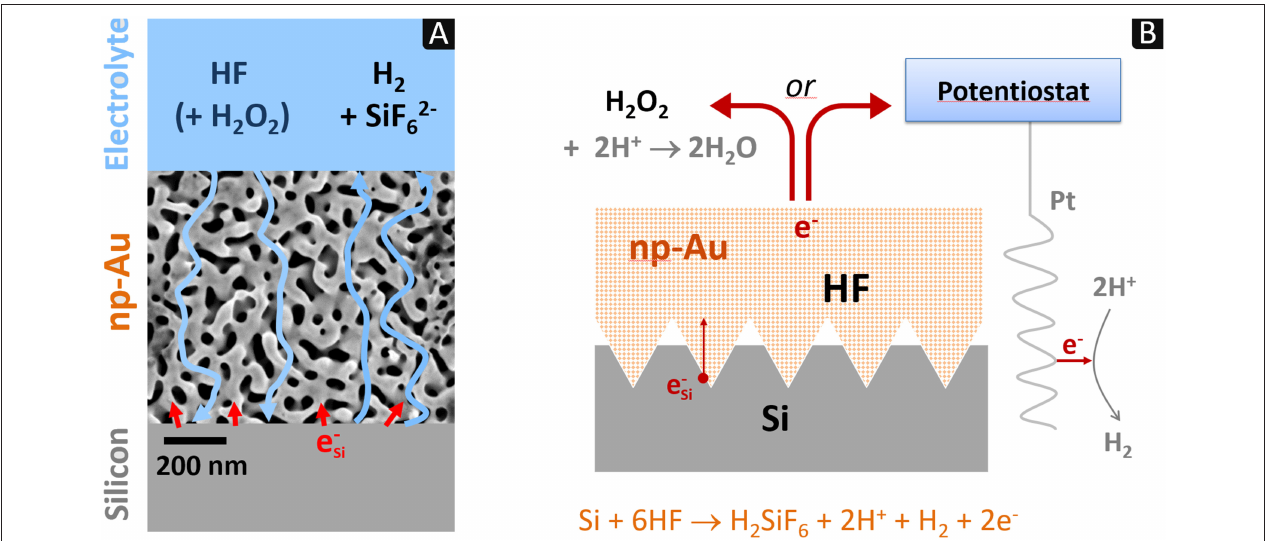
FIGURE 1 | Scheme of the contact etching process: (A) diagram of the fluxes of electrons (red arrows) and chemicals (blue arrows) through a macroscopic piece of np-Au showing the nanometer-scale Au/Si contacts; (B) principle of 3D imprinting of silicon using a np-Au electrode with a pattern consisting in pyramids. Anodic polarization of the electrode can be provided either through an external circuit (electrochemical contact etching) or in situ by H 2 O 2 (chemical contact